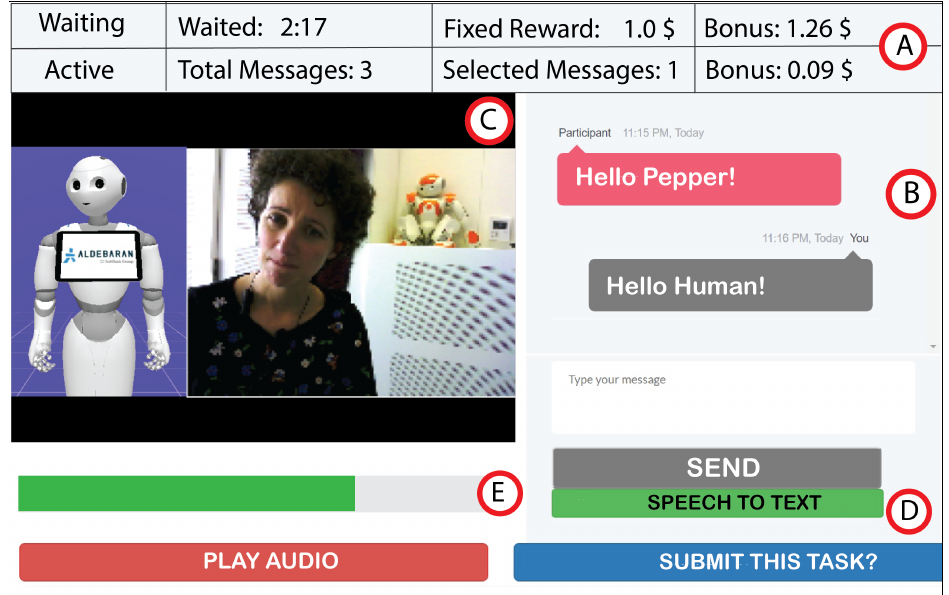
Figure 3. Crowd worker’s main task page. It also shows an actress interacting with the CoZ from one of the